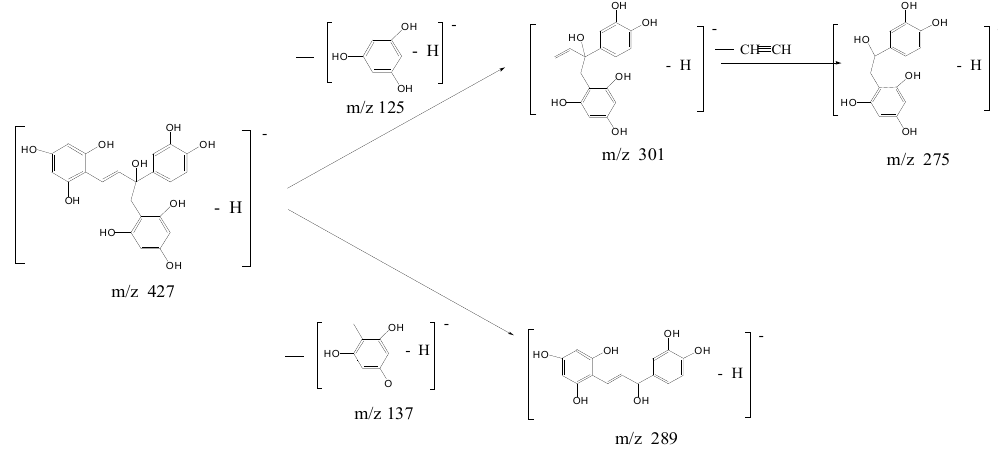
Figure 3. The ultra performance liquid chromatography (UPLC) and mass spectrometry (MS) information of UVB irradiated EC in ethanol after concentration. Inset P6-9: the MS/MS spectra of photoproducts assigned to P6-9.